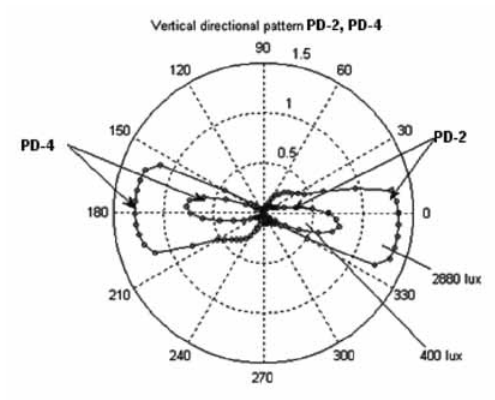
Fig. 10. Vertical directional diagrams of PD-2, PD-4